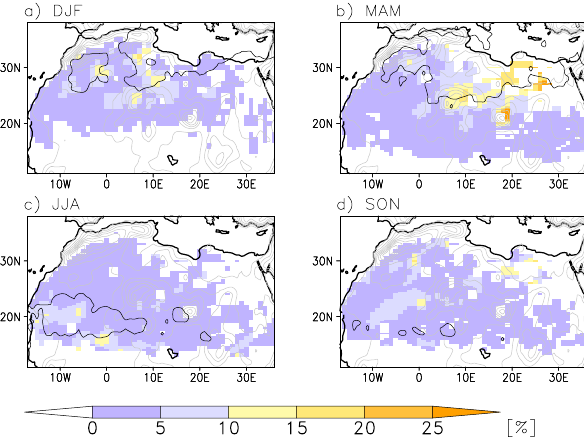
Figure 11. Seasonal dust emission associated with long-lived and migrating cyclones. Shown are mean emissions (shaded) for (a) December–February, (b) March–May, (c) June–August and (d) September–November averaged for 1989–2008. Blue contours show the number of intense dust emission events, defined by a flux larger than 10 − 5 gm − 2 s − 1 following Laurent et al. (2010), in steps of three events. Grey contours show the orography in steps of 200m.